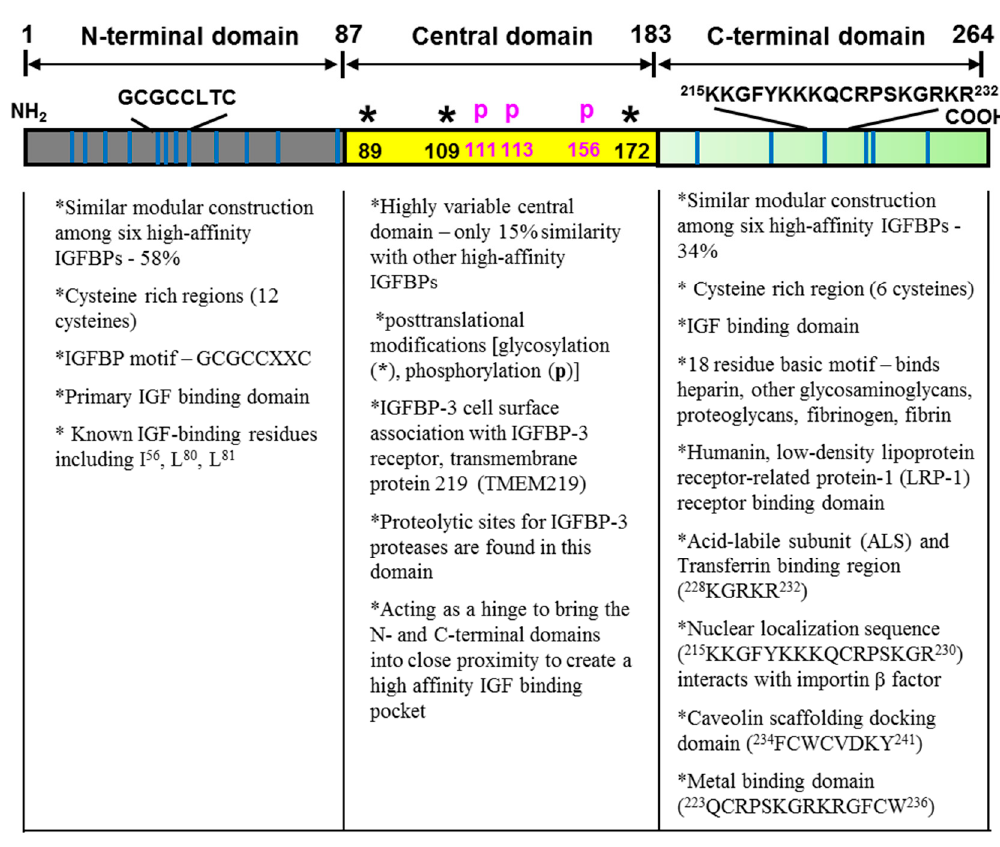
Figure 1. Structure of the mature human IGFBP-3. This figure depicts the three distinct domains of the IGFBP-3 and lists the important functions and motifs/residues within each domain [3]. The vertical blue lines represent 18 cysteine residues in highly conserved N -terminal and C -terminal